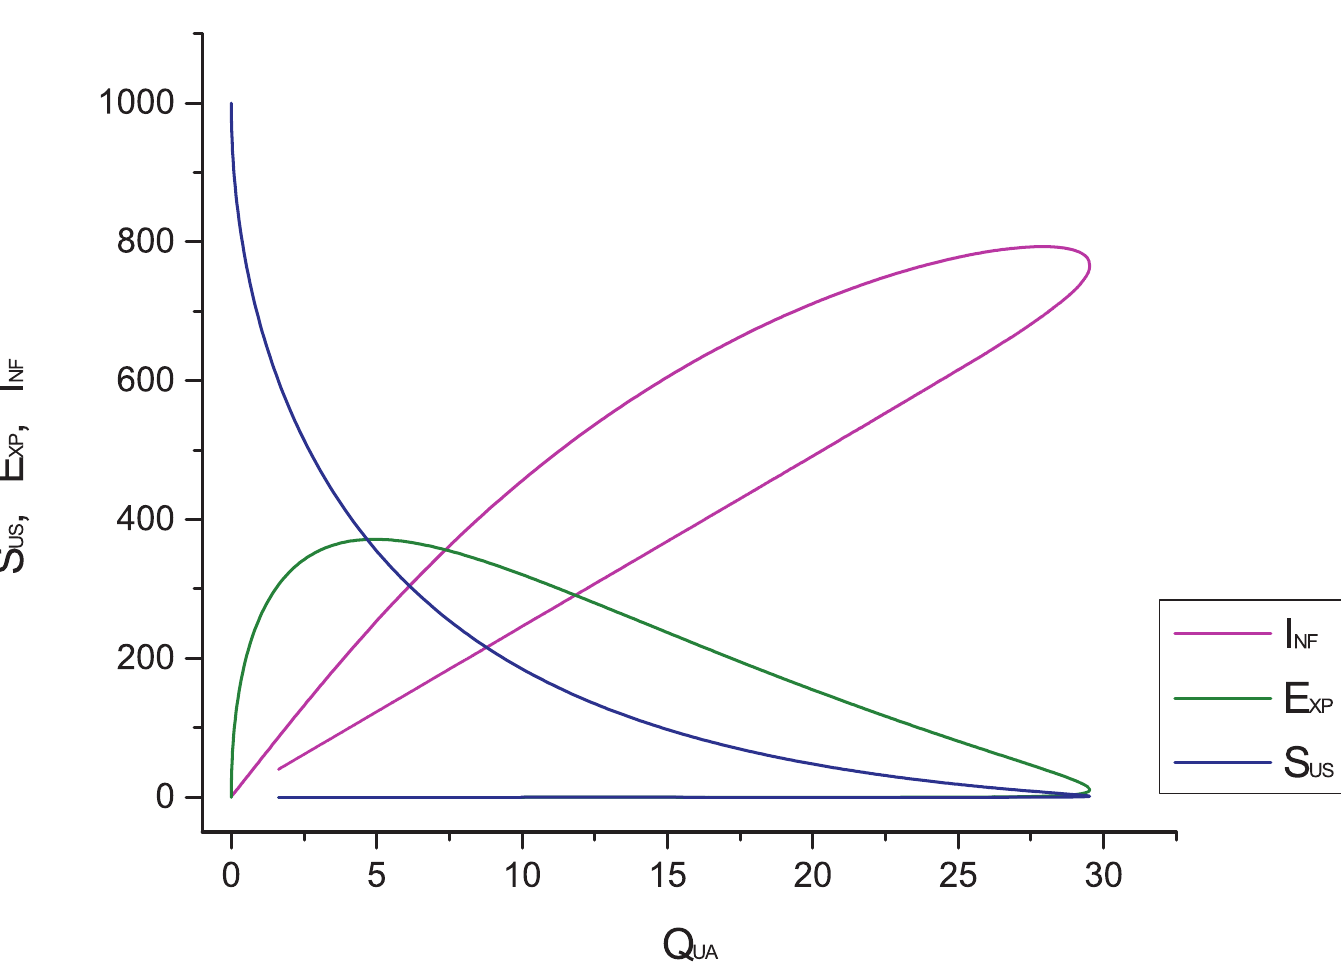
Fig 9. Quarantine effect on different